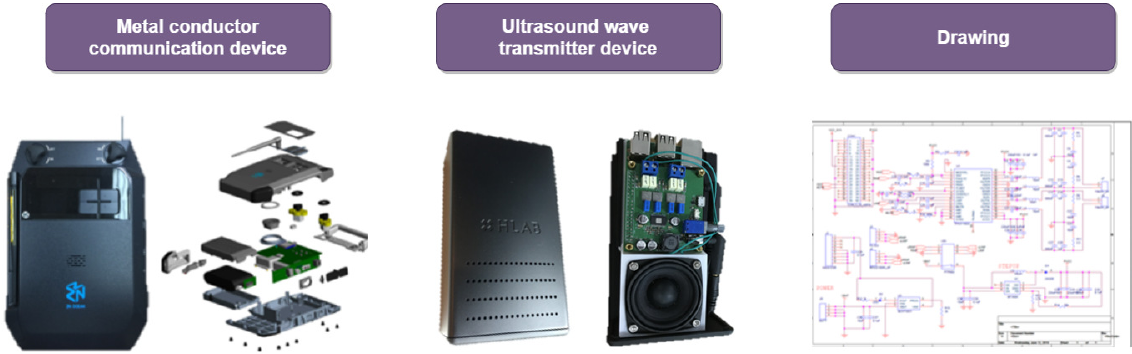
Figure 6. Prototype devices.